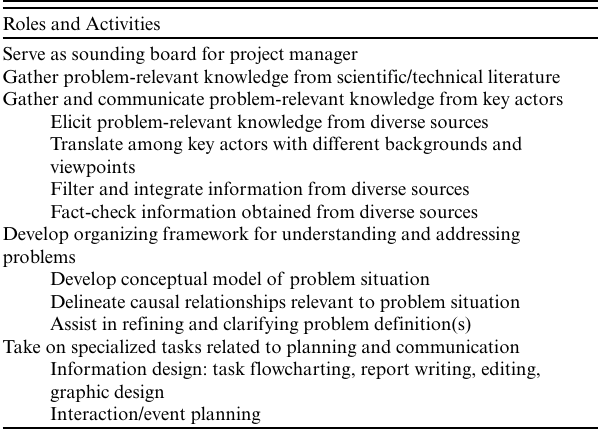
Table 1 . Potential roles and activities for knowledge brokers